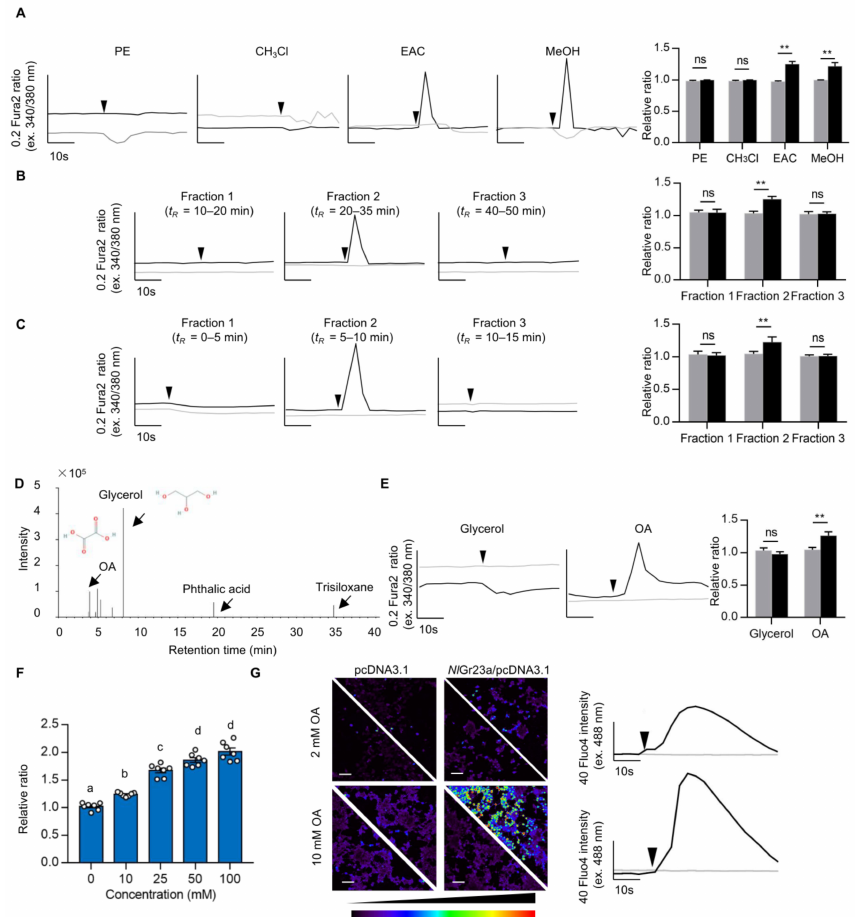
Figure 1. Oxalic acid is a ligand of Nl Gr23a. ( A ) Round 1 of ligand screening. The responses of Sf9 cells transfected with pIZ- Nl Gr23a-V5-His (black lines) or pIZ-V5-His (grey lines) vector to different fractions from the crude extract of rice plants separated by petroleum ether (PE), chloroform (CHCl 3 ), ethyl acetate (EAC), and methyl alcohol (MeOH) were analyzed by calcium imaging. The changes in intracellular Ca 2+ are indicated by the ratio of F 340 /F 380 in Fura2-AM loaded cells. Each curve represents one cell responding to a specific fraction. The vertical scale bar indicates 0.2 ratio of